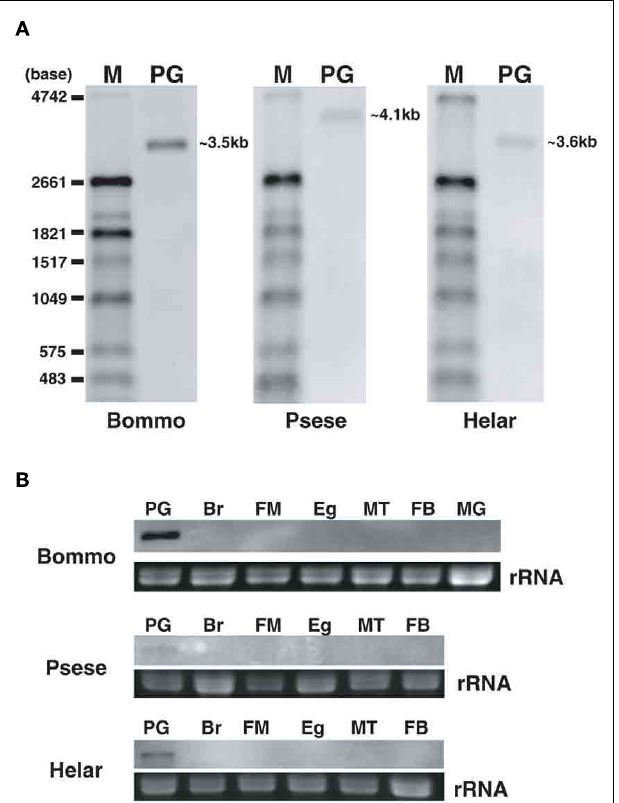
FIGURE 10 | Northern blot analyses of PBANR variants in adult female tissues. (A) PG. (B) Adult tissues. Using two probes (BommoPBANR-A: 1–1265, BommoPBANR-C: 1591–2616, PsesePBANR-A: 254–1378, PsesePBANR-C: 1586–2608, HelarPBANR-A: 242–1282 and HelarPBANR-C: 1574–2597) that recognize either the “short” PBANR variants or the “long” variants. A single 3.4–4.1kb band corresponding